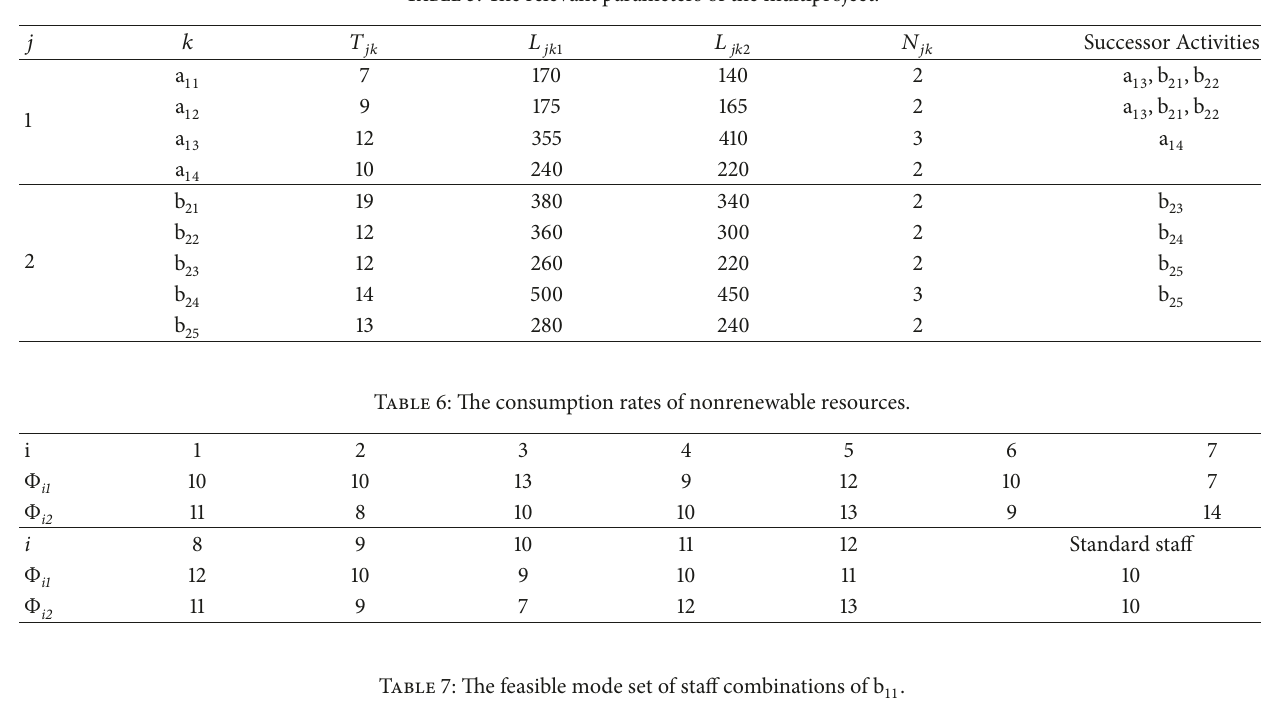
Table 5: The relevant parameters of the multiproject.